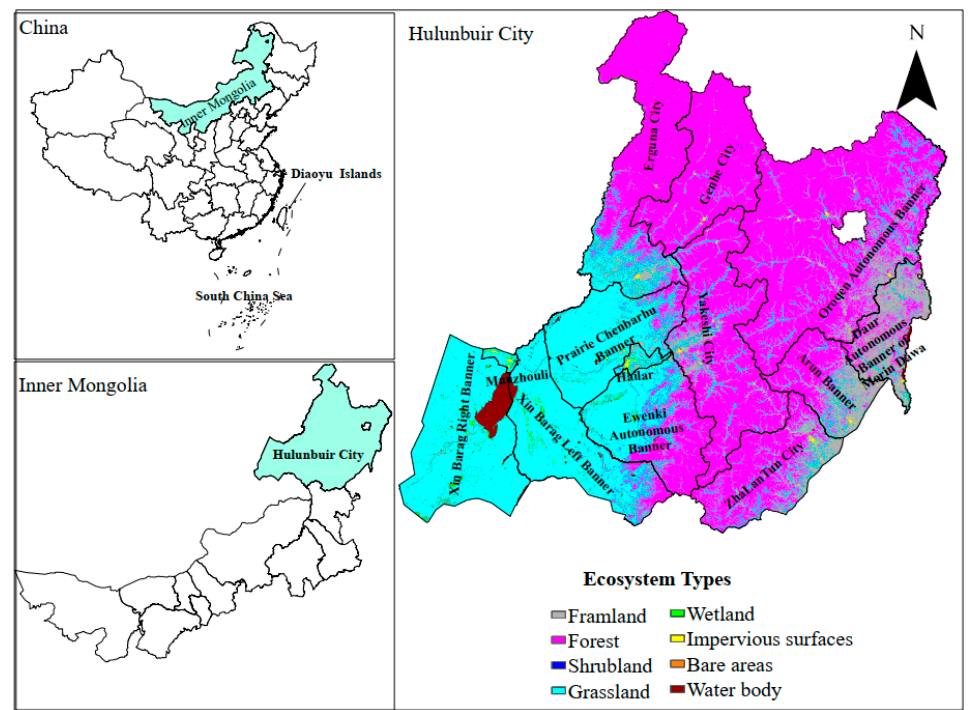
Figure 1. The ecosystem types of the study area (Hulunbuir City, China).